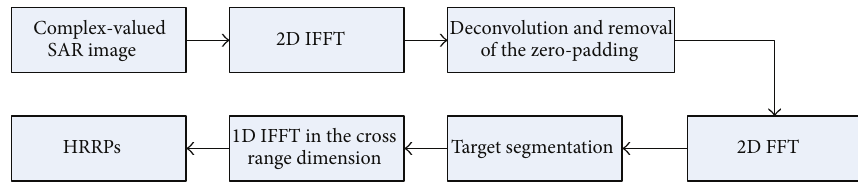
Figure 1: The procedure from a SAR image to